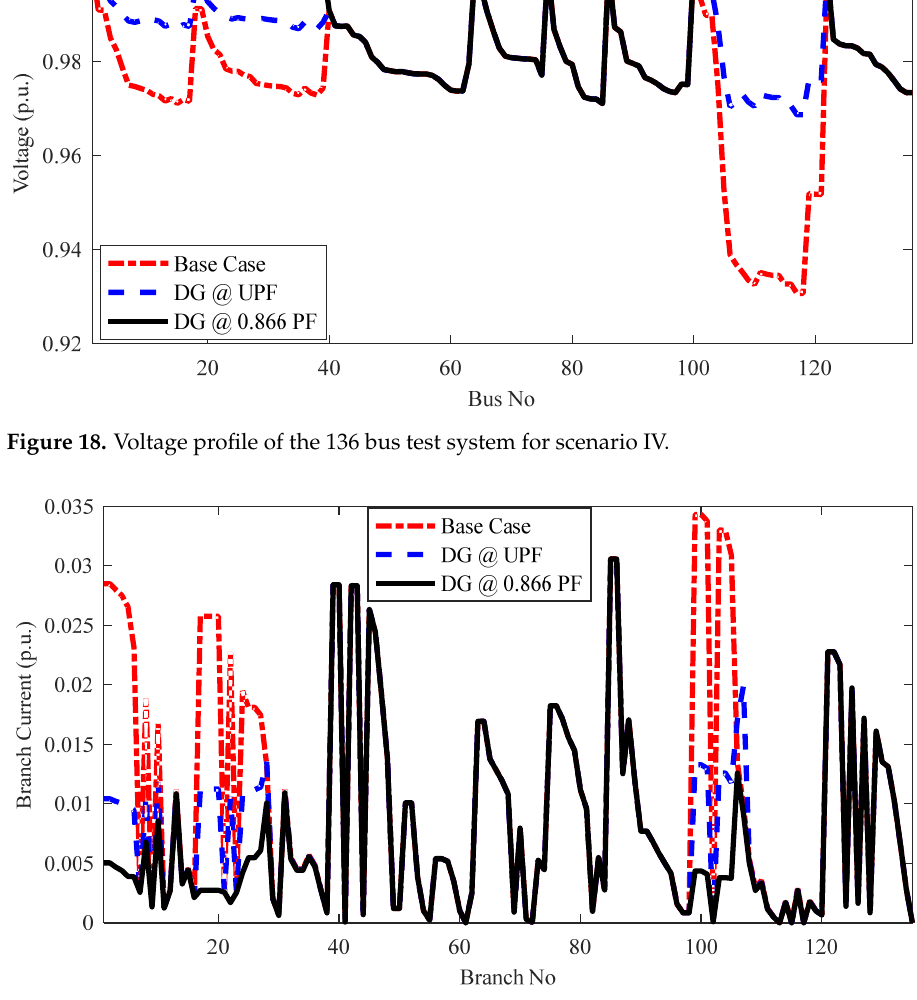
Figure 19. Branch current profile of the 136 bus test system for scenario IV.